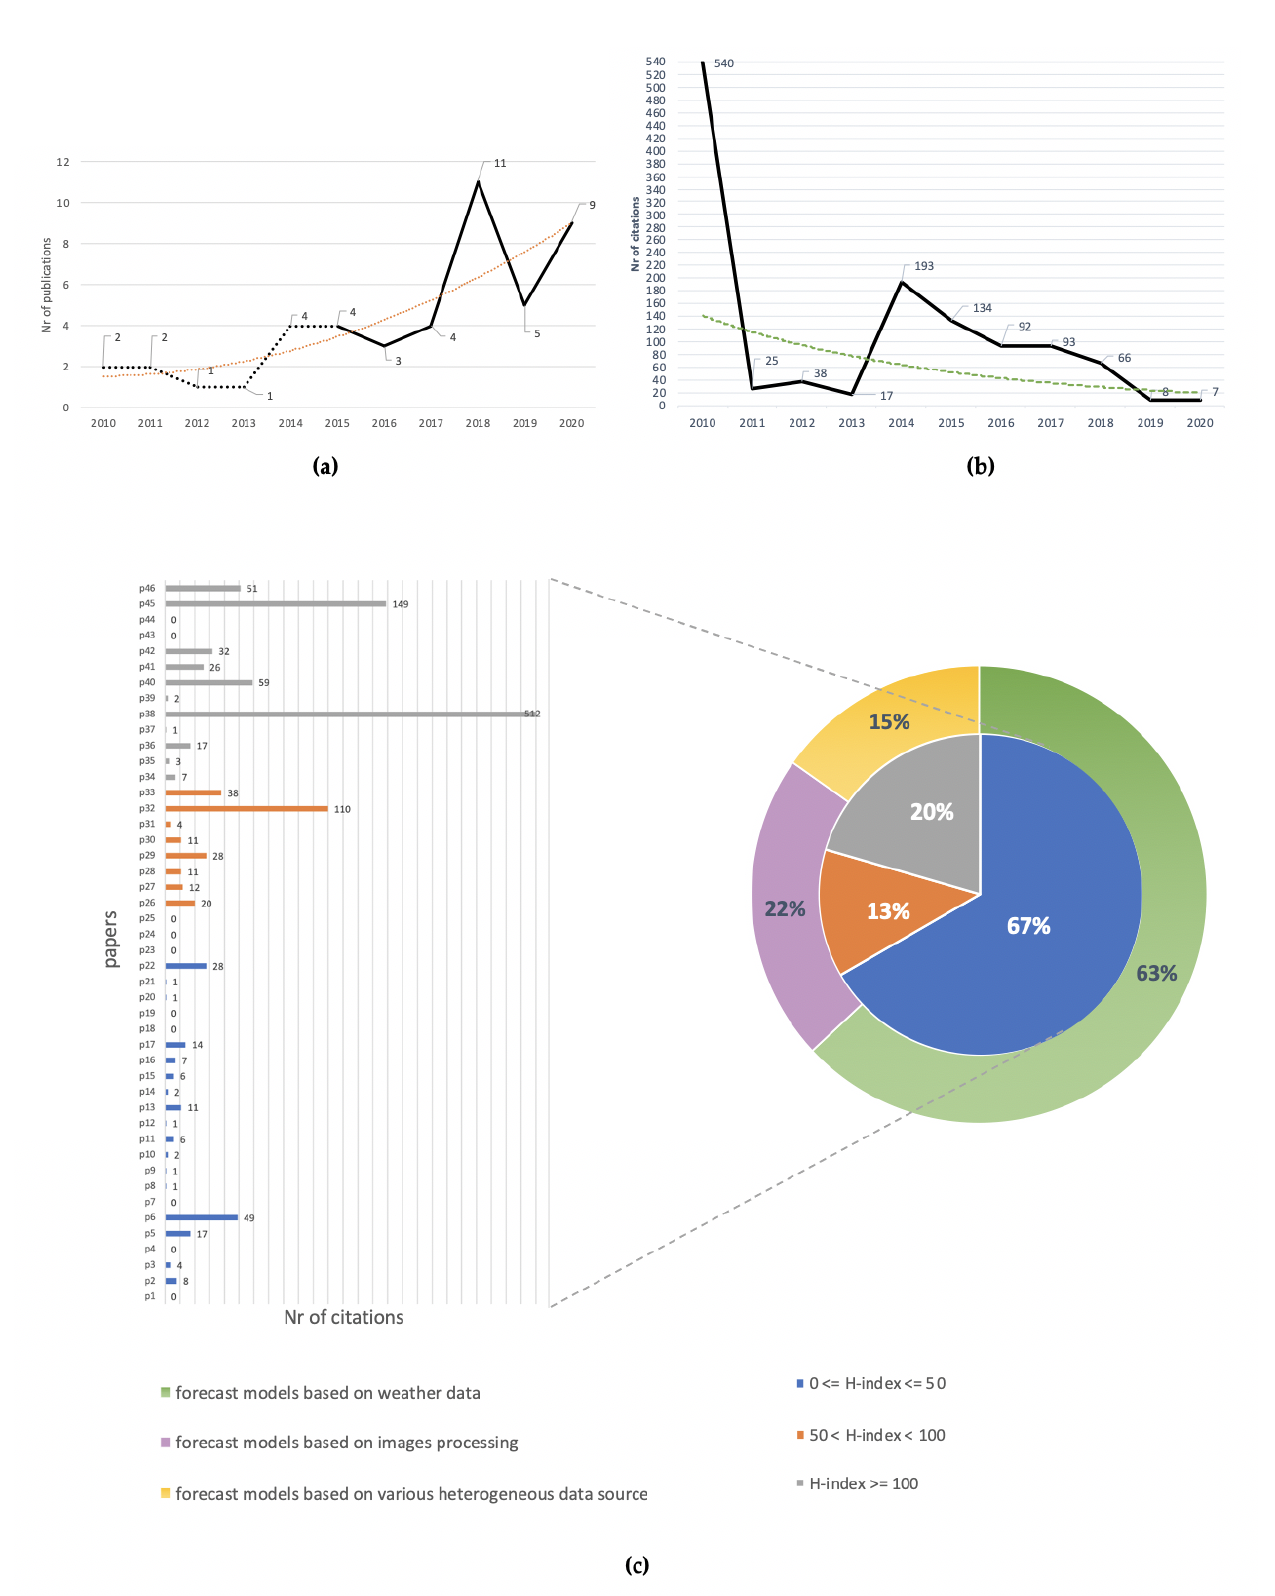
Figure 3. ( a ) Number of research publications per year (2010–2020) related to plant and crop disease prediction, which predicted the onset of the disease in a pre-symptomatic (i.e., symptoms not visible to the naked eye) or early stage, recovered by adopting the methodology described in Section 2.1; ( b ) number of citations for each year considered; ( c ) number of citations for each paper, which have been grouped according to the journal’s